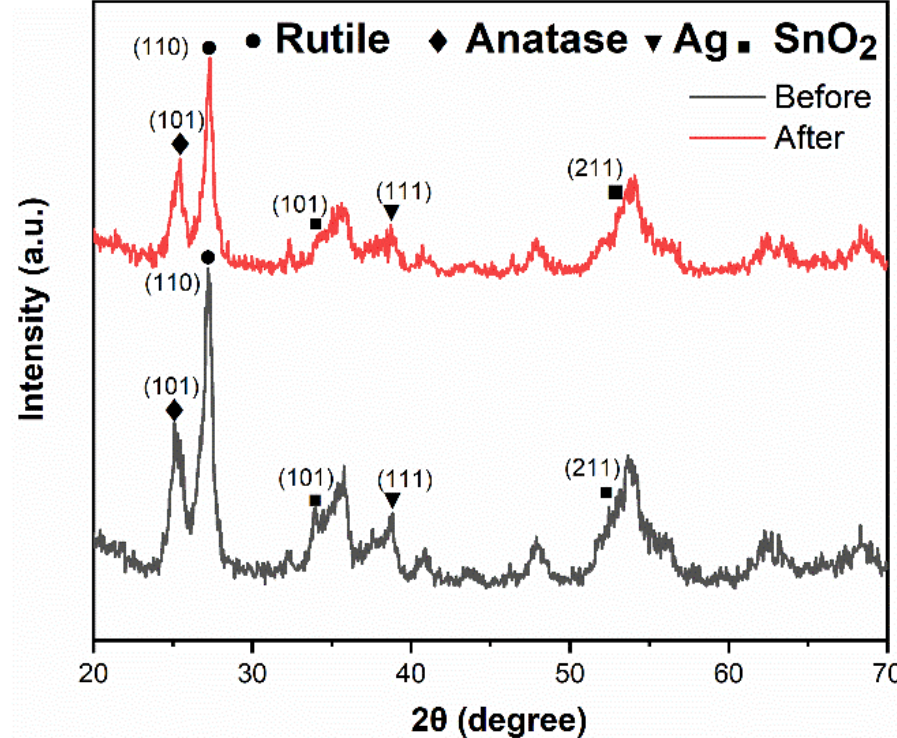
Figure 12. XRD patterns of Ag@SnO 2 /TiO 2 photocatalyst before and after the photocatalytic experi- ment.